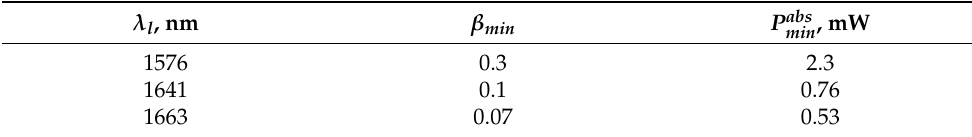
Table 5. Calculated P abs , and β min for different laser min